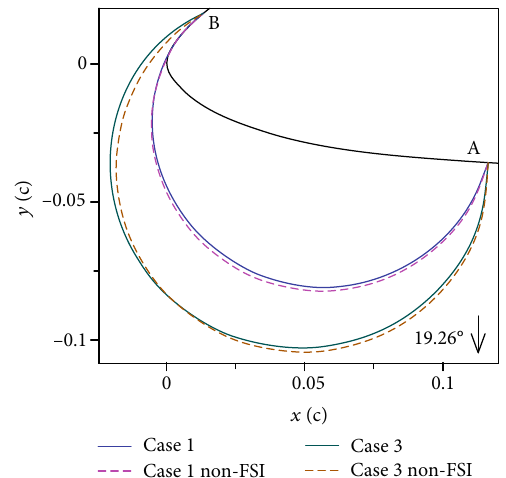
Figure 22: ILE shapes at an angle of attack of 19.26deg downstroke in airfoil frame of